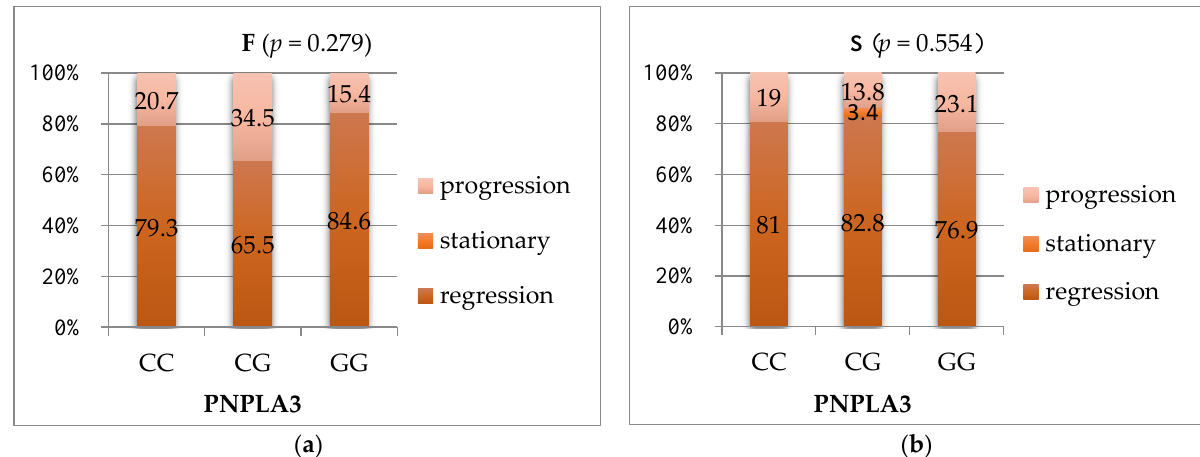
Figure 3. ( a ) Correlation three monthspost-SVR evolution of fibrosis with PNPLA3 genotype; ( b ) Correlation three